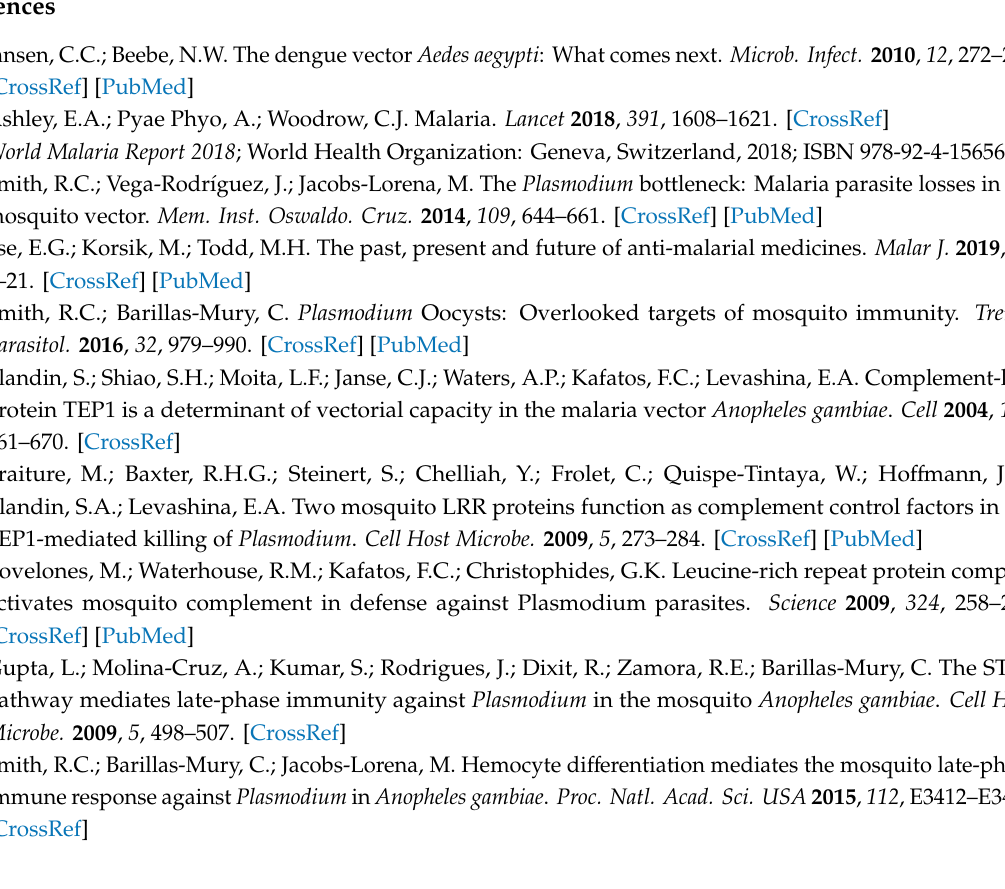
Table S1: Primers used for dsRNA synthesis and